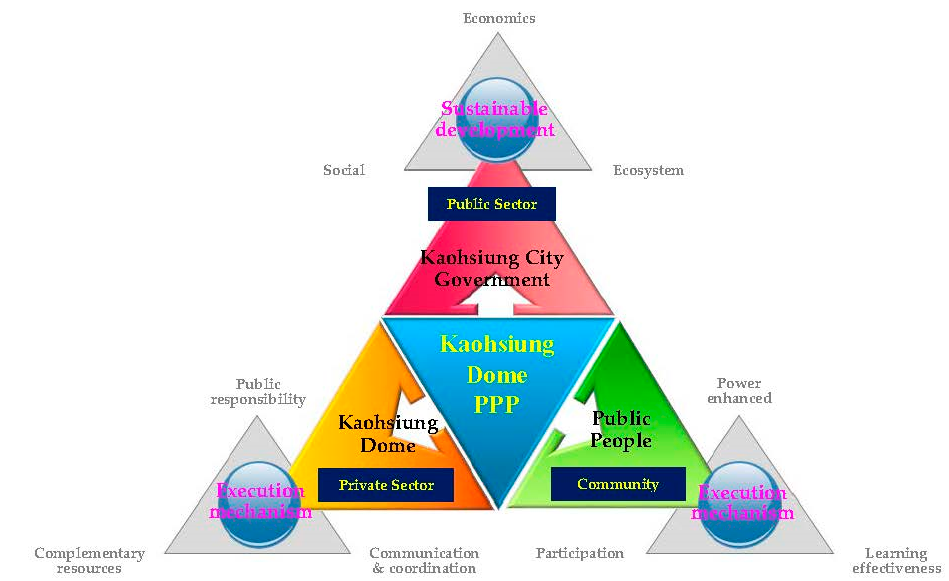
Figure 10. Win-win-win PPP strategy of Kaohsiung Dome.